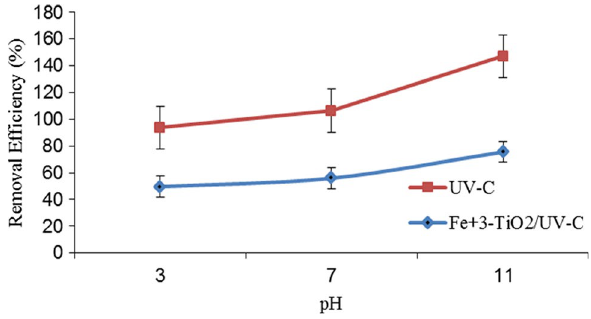
Fig. 9 t = 30 min, Fe +3 –TiO